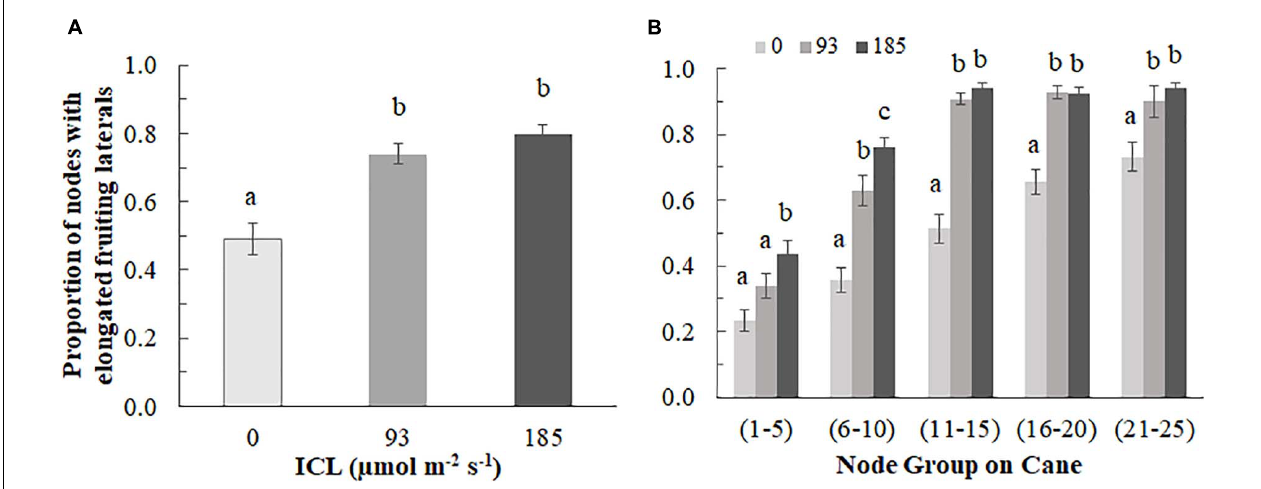
FIGURE 2 | Proportion of buds with elongated fruiting laterals ( > 3 cm) per blackberry cane for 0, 93, or 185 µ mol m − 2 s − 1 ICL (A) on the entire cane and (B) by bud position group (counting from the base of the cane). Data is an average of observations from destructive harvests on 14 March, 4 April, 24 April, and 11 July. (A) Different letters indicate significant differences according to Fisher’s protected LSD-test ( P = 0.05); (B) Different letters within a bud position group, indicate significant differences (Mann-Whitney test, P = 0.05). Error bars indicate SEM ( n = 6).